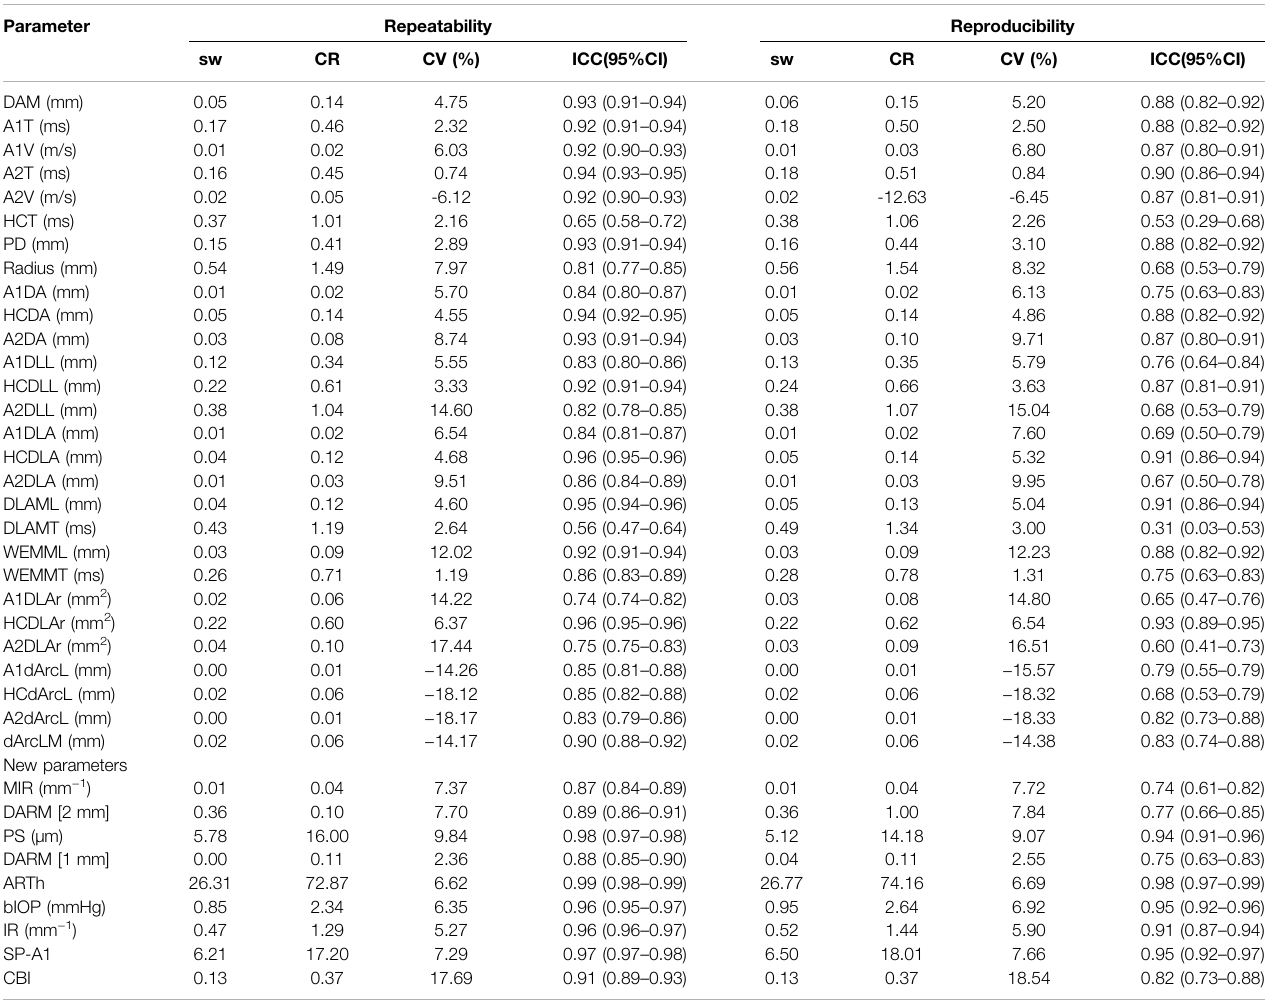
TABLE 4 | Repeatability and reproducibility of the Corvis ST parameters in healthy eyes. Parameter